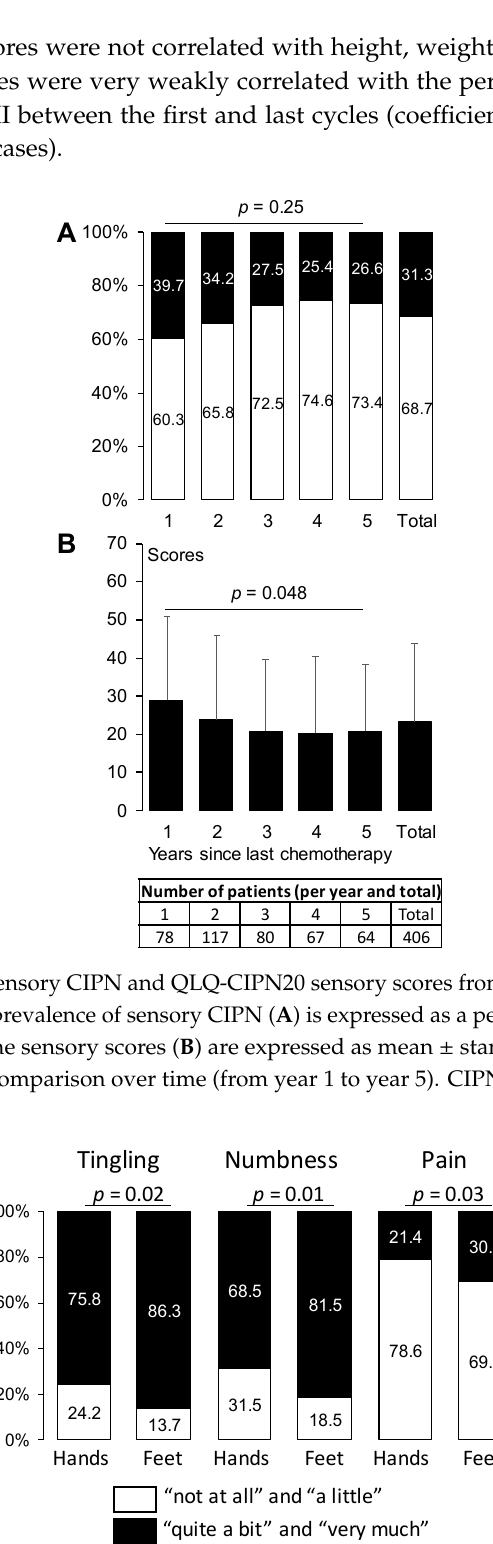
Figure 3. Severity proportions of the QLQ-CIPN20 items assessing tingling, numbness, and pain in the hands and feet among patients with sensory CIPN. The response categories were recoded to yield a dichotomous outcome per item (white: “not at all” or “a little” vs. black: “quite a bit” or “very much”). Results are expressed by percentage.